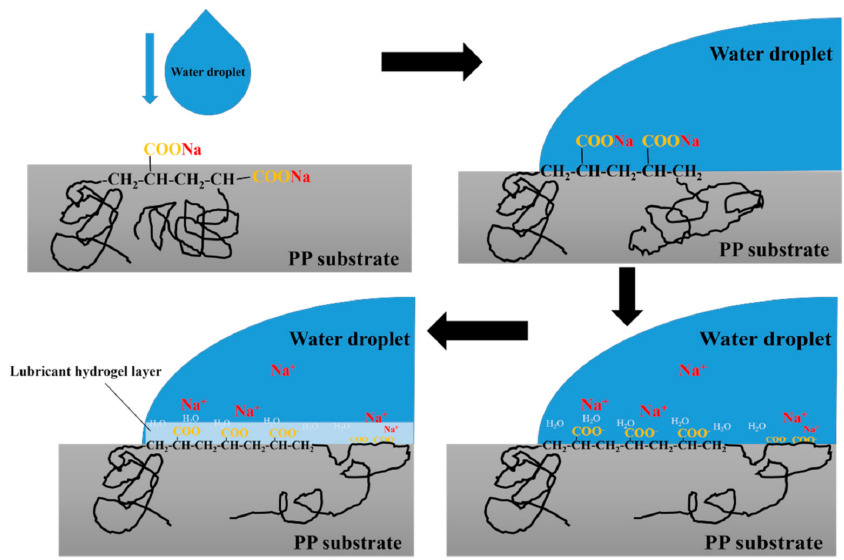
Figure 9. Scheme for the formation of lubricant hydrogel layer on the interface between water and